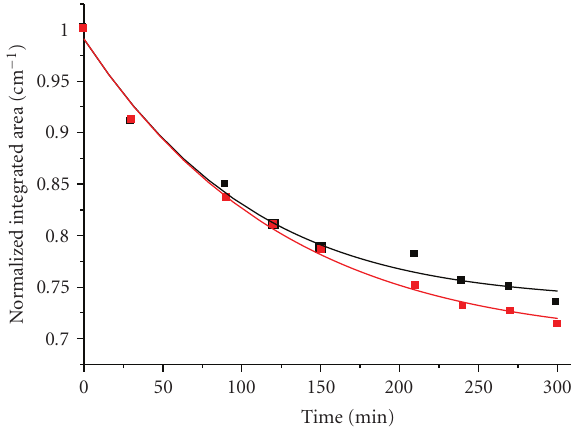
Figure 8: Visible activity of Ag on TiO 2 compared to that of TiO 2